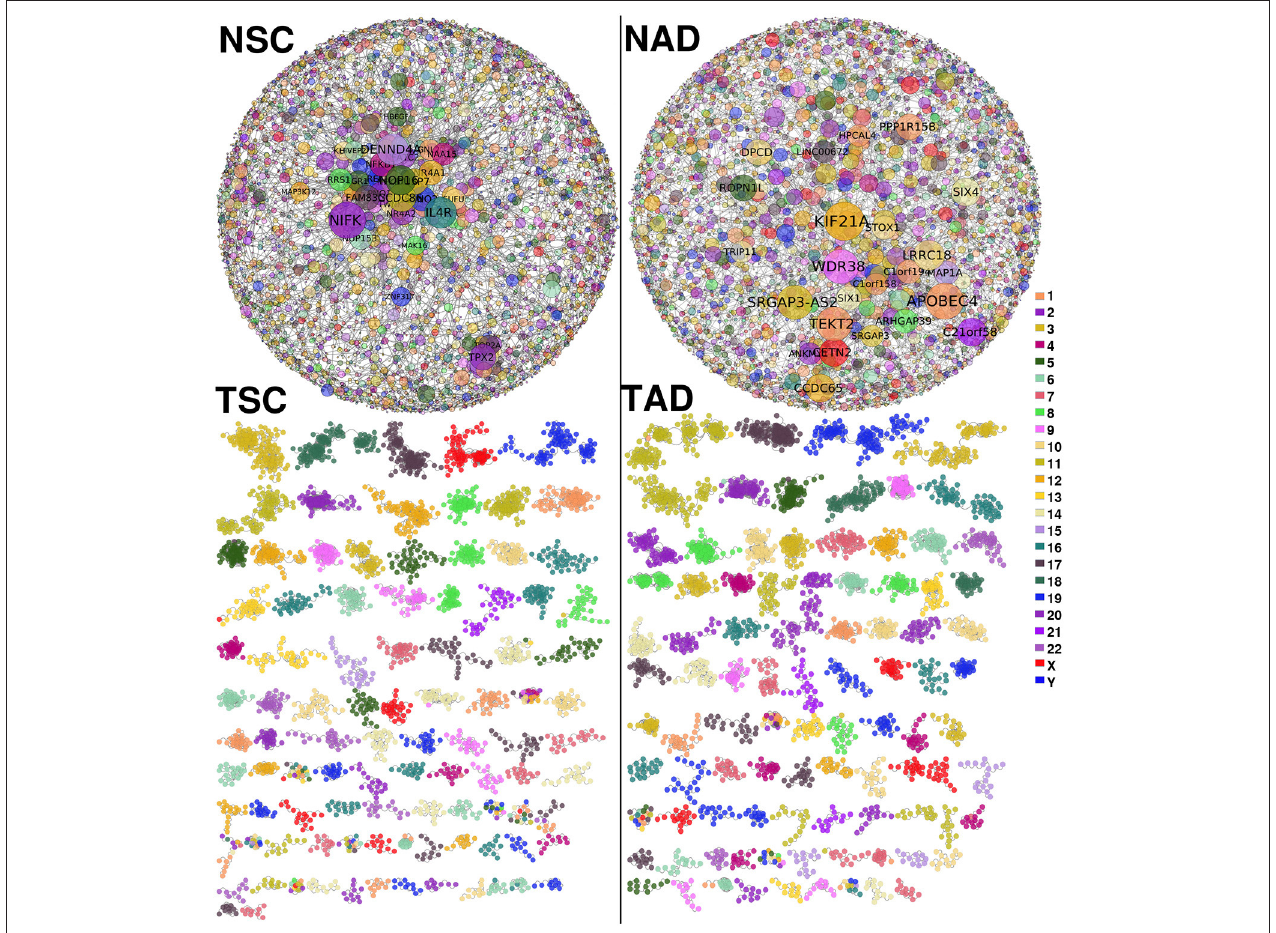
FIGURE 2 | Non-small cell lung cancer (NSCLC) and normal tissue-derived gene co-expression networks. (Top-left) Largest component of normal tissue-derived network for NSC. (Top-right) Correspond to the giant component of NAD gene co-expression network (GCN). (Bottom-left) Squamous carcinoma-derived gene co-expression network. (Bottom-right) Tumor adenocarcinoma network. In both tumor GCNs, components with more than 10 genes are depicted. Genes are colored according to the chromosome location. In healthy GCNs, gene size is proportional to the gene